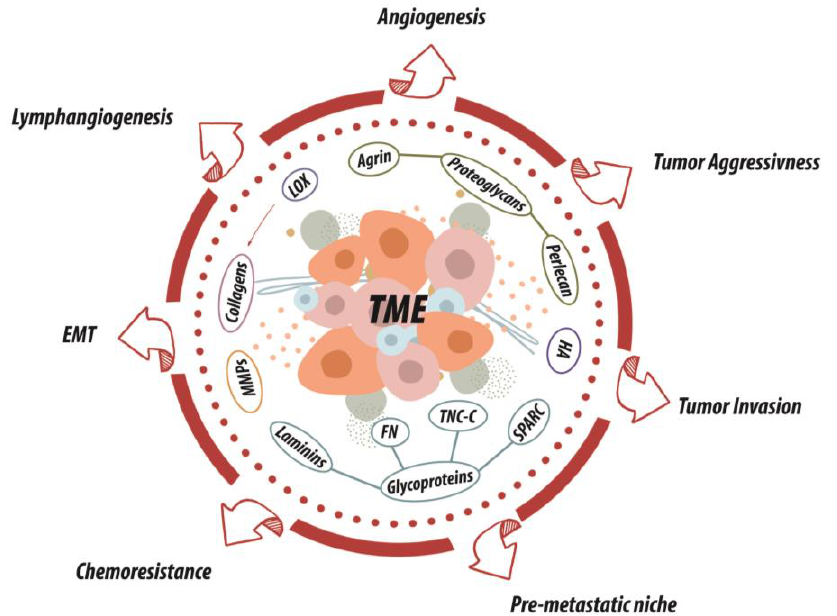
Figure 2. Schematic representation of the major ECM molecules affecting multiple aspects of UADT SCC development. TheECM molecules interact with different proteins, growth factors and receptors impacting on several processes determining the fate of the SCC, such as: angiogenesis, lymphangio- genesis, tumor aggressiveness and invasion, pre-metastatic niche establishment, chemoresistance, and epithelial-mesenchymal transition